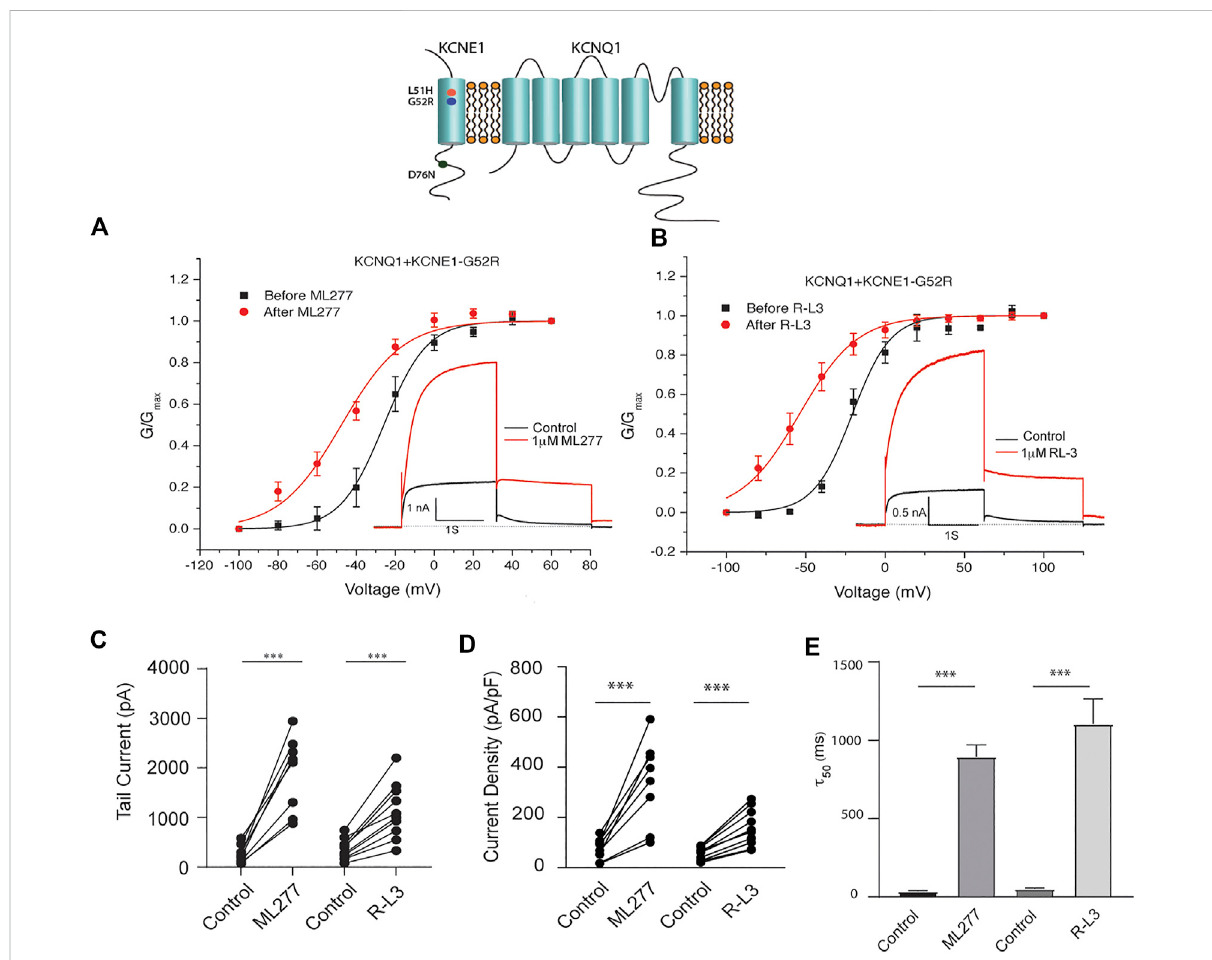
FIGURE 5 PotentiationofKCNQ1-G52RchannelactivitybyML277andR-L3. (A) .Normalizedconductance/voltagerelationshipforKCNQ1-KCNE1-G52R channels before (black traces) and after (red traces) application of 1 μ M ML277. The inset shows representative currents recorded at +60 mV. (B) . Normalized conductance/voltage relationship for KCNQ1-KCNE1-G52R channels before (black traces) and after (red traces) application of 1 μ M R-L3. The inset shows representative currents recorded at +60 mV. (C) . Deactivation of tail current amplitude measured at − 40 mV in control and 1 μ M ML277 and 1 μ M R-L3 solutions. (D) . Summarydata for peak KCNQ1/KCNE1-G52R channel activity measured 2 s at +60 mV in control